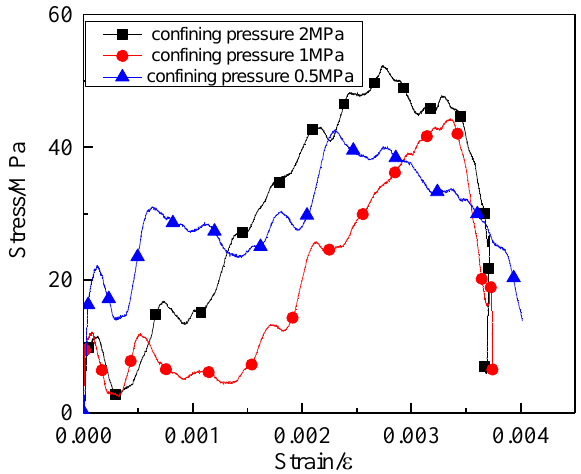
Figure 14. Dynamic stress–strain curve of mudstone-like material under active confining pressure.